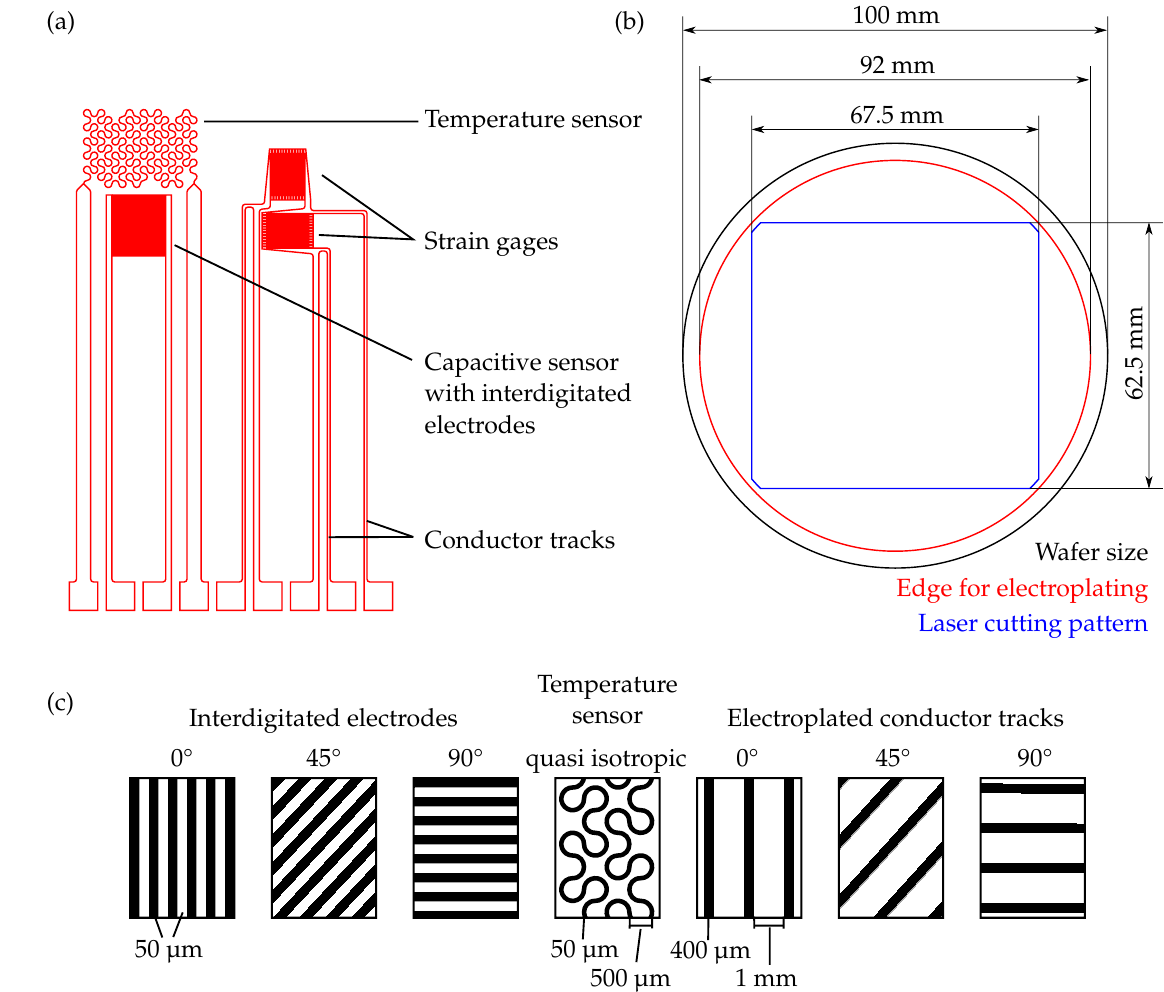
Figure 2. Sensor prototype and characteristic zones of the sensor geometry for ILS tests: ( a ) Sensor prototype [27]. ( b ) Laser cutting pattern. ( c ) Characteristic patterns, that were integrated into ILS specimens, not true to scale to make the conductor tracks